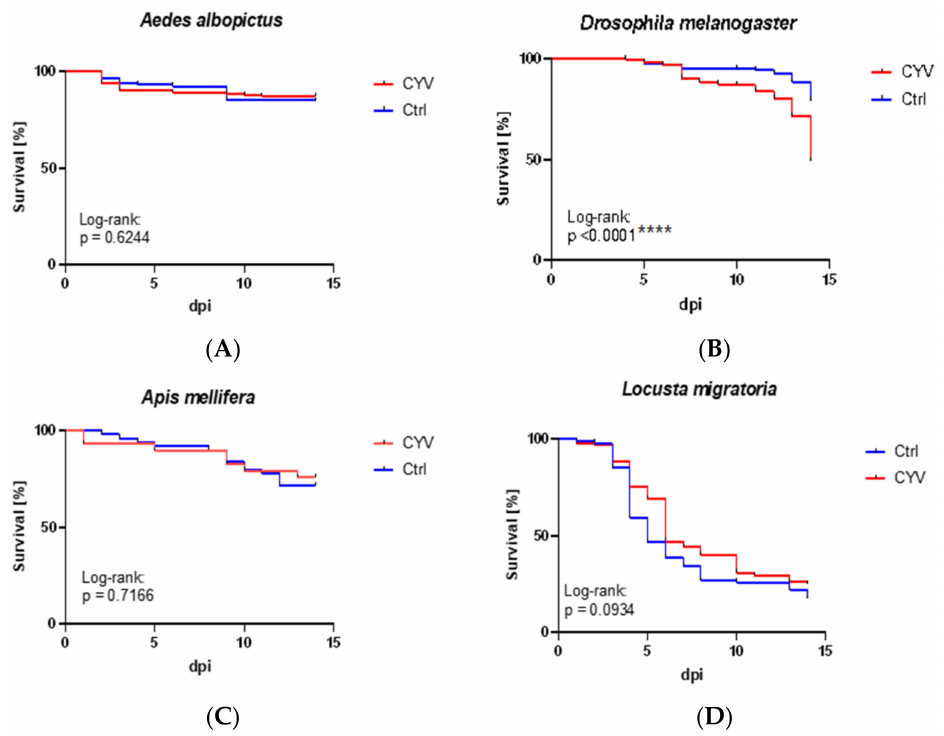
Figure 9. Survival curves. The data represent the survival rates in percentages over days post- infection (dpi). ( A ) Ae. albobictus : CYV-injected vs. medium-injected; Log-rank: p = 0.6244 (ns). ( B ) D. melanogaster : CYV-injected vs. medium-injected; Log-rank: p = <0.0001 (****). ( C ) A. mellifera : CYV-injected vs. medium-injected; Log-rank: p = 0.7166 (ns); two replicates. ( D ) L. migratoria : CYV- fed females vs. medium-fed females; Log-rank: p = 0.0797 (ns). Red curve—CYV-infected insects; blue curve—control (Ctrl)